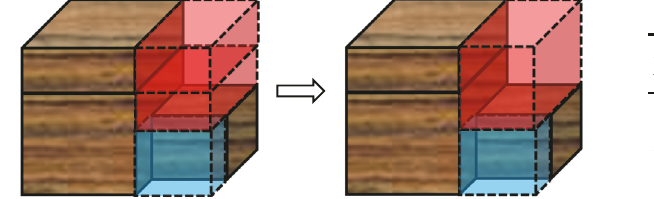
Figure 7: Up-and-down space consolidation.